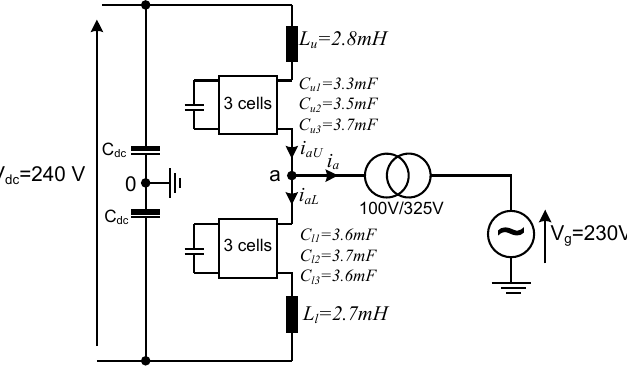
Figure 15. Experimental test of a 3-cell HB-MMC.